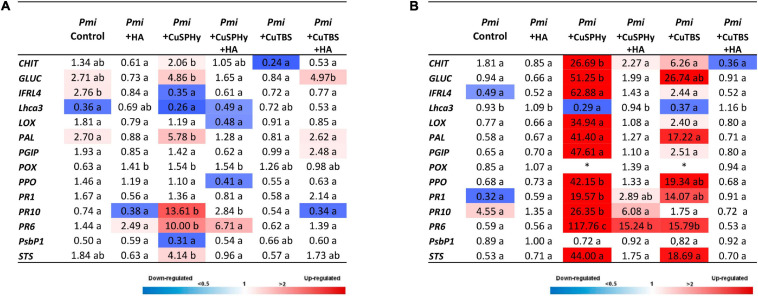
Expression levels of the selected 14 genes recorded by RT-qPCR in Phaeoacremonium minimum (Pmi) artificially inoculated grafted vines according to the applied foliar treatments (HA, CuSPHy, CuSPHy + HA, CuTBS, and CuTBS + HA) and two different detection times: 8 h (A) and 24 h (B) after the last foliar treatment. Values (the mean of three technical replicates) represent the expression levels (ΔΔCt) of reported conditions relatively to the control (non-inoculated and untreated plant material). Expression of a given gene was considered up- or down-regulated when the value of relative expression was > 2-fold or < 0.5-fold compared to the control, respectively. The same letter indicates no statistically significant differences for P ≤ 0.05 between values of different foliar treatments. (*) Gene values not available due to problems of transcription.